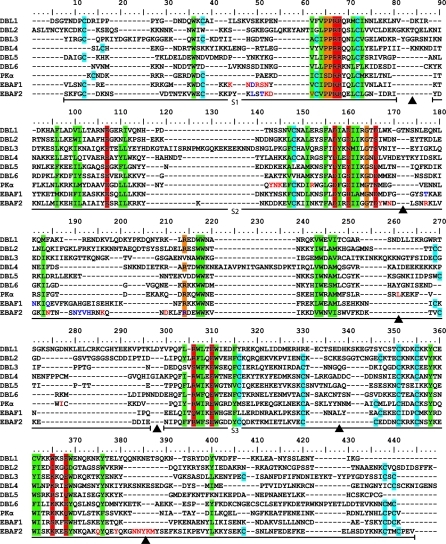
A Structural Alignment of the Template Structures EBA-175 F1 and F2 and Pkα-DBL and the Six VAR2CSA DBL ModelsVertical color bars denote positions of stabilizing residues in template structures. Blue bars denote cysteines forming disulfide bonds, green bars denote buried hydrophobic residues, orange bars denote helix capping residues, and red bars denote buried polar/charged residues. The location of sub-domains S1–S3 are marked by horizontal black bars, and regions of missing structural information in the template structures are marked by black arrowheads. Residues involved in GAG binding of EBA-175 DBL domains or DARC receptor binding of Pkα-DBL are marked with red letters. EBA-175 residues involved in dimerization are marked in blue letters.